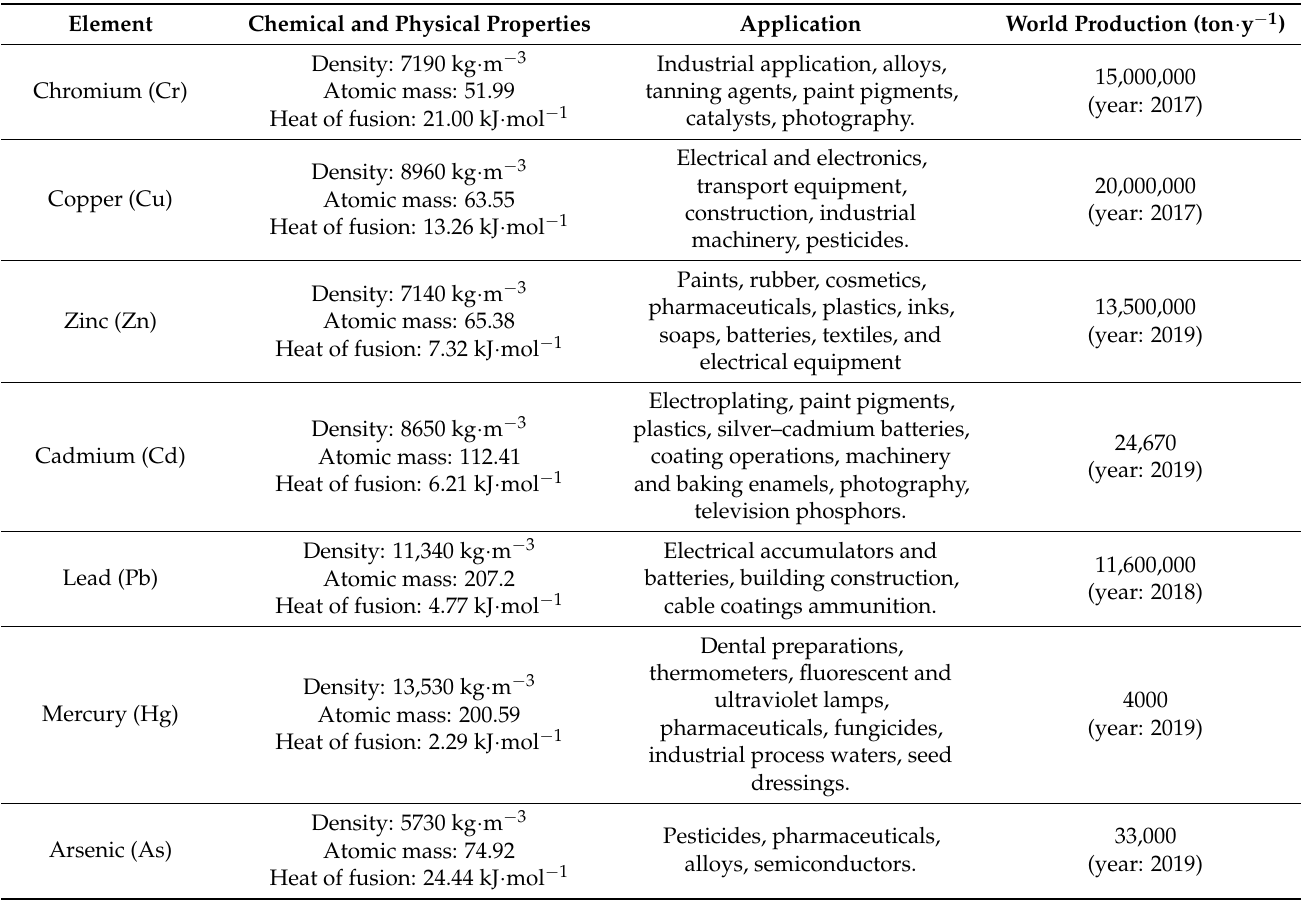
Table 1. Heavy metals and metalloids characteristics.